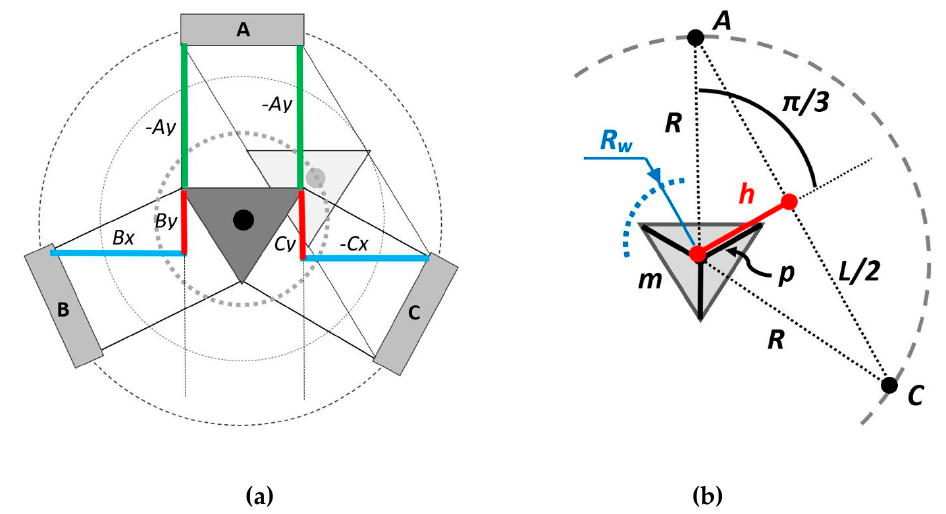
Figure 4. Calibration parameters and geometric constraints of the hybrid printer. ( a ) calibration parameters, ( b ) end effector movement constraints: R w —radius of the printing (working) zone, R —distance between the anchor and the geometric center of the print surface, h —distance to the AC chord, p —distance to the mass center of the equilateral triangle (nozzle support structure), L —length of the AC chord, m —nozzle support structure side length, and π /3—half of the central angle. Parallel wires prevent the end effector from rotating around its own axis while mov-